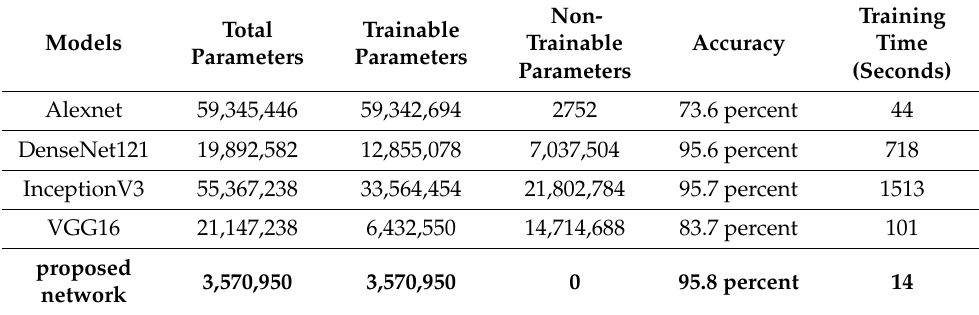
Table 3. Comparison of the proposed model and SOTA